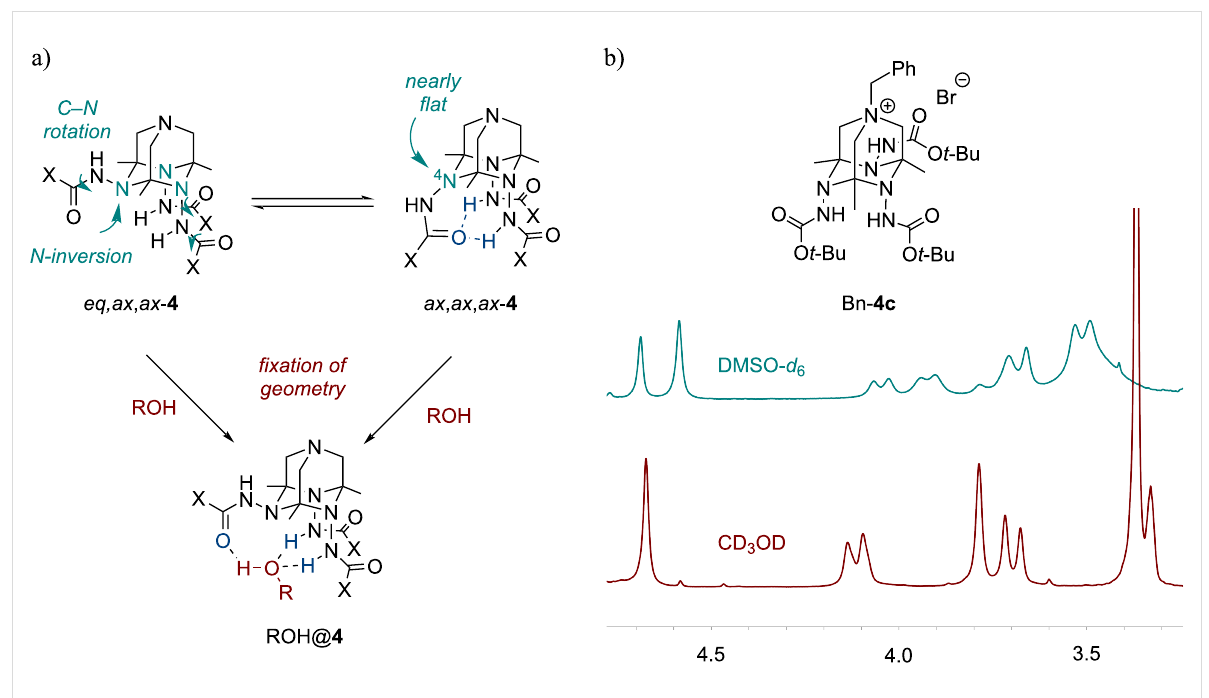
Figure 4: (a) Dynamic processes in TAADs 4 and complexation with ROH. (b) Fragment of 1 H NMR spectra of Bn- 4c in DMSO- d 6 and CD 3 OD.